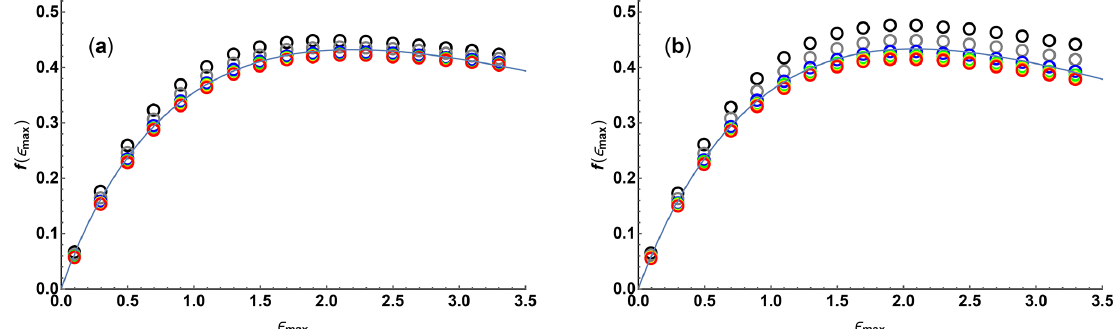
Figure 2. Relative diffusion resolution f ( (cid:15) max ) determined Cramér–Rao least bounds analysis (open circles) as a function of maximum Stejskal–Tanner exponent (cid:15) max , for (a) linear and (b) quadratic sampling in the gradient domain with 10 (black), 17 (grey), 37 (blue), 65 (green), 101 (yellow), and 197 (red) gradient values. Solid lines show the results of nonlinear regression of the data points shown to the three-parameter function Eq.